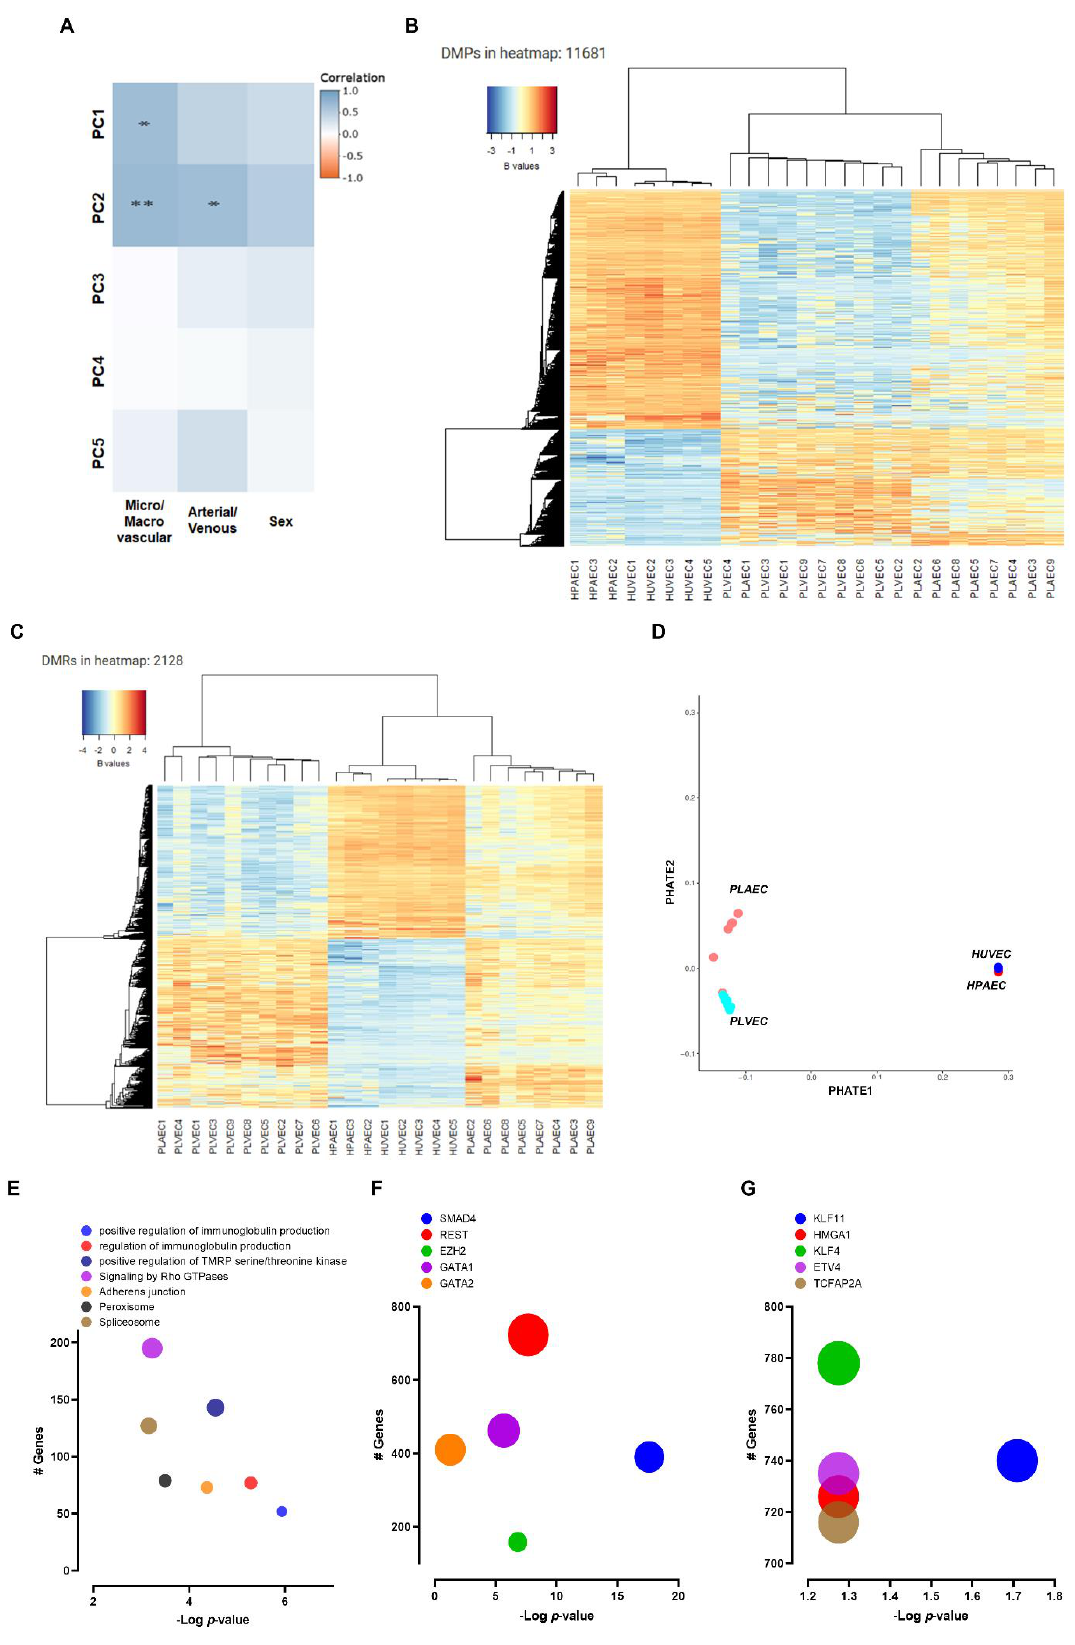
Figure 4. DNA methylation profile of micro- and macro-vascular endothelial cells. ( A ) PCA analysis for the first five principal components for micro- and macro-vascular, arterio-venous, and